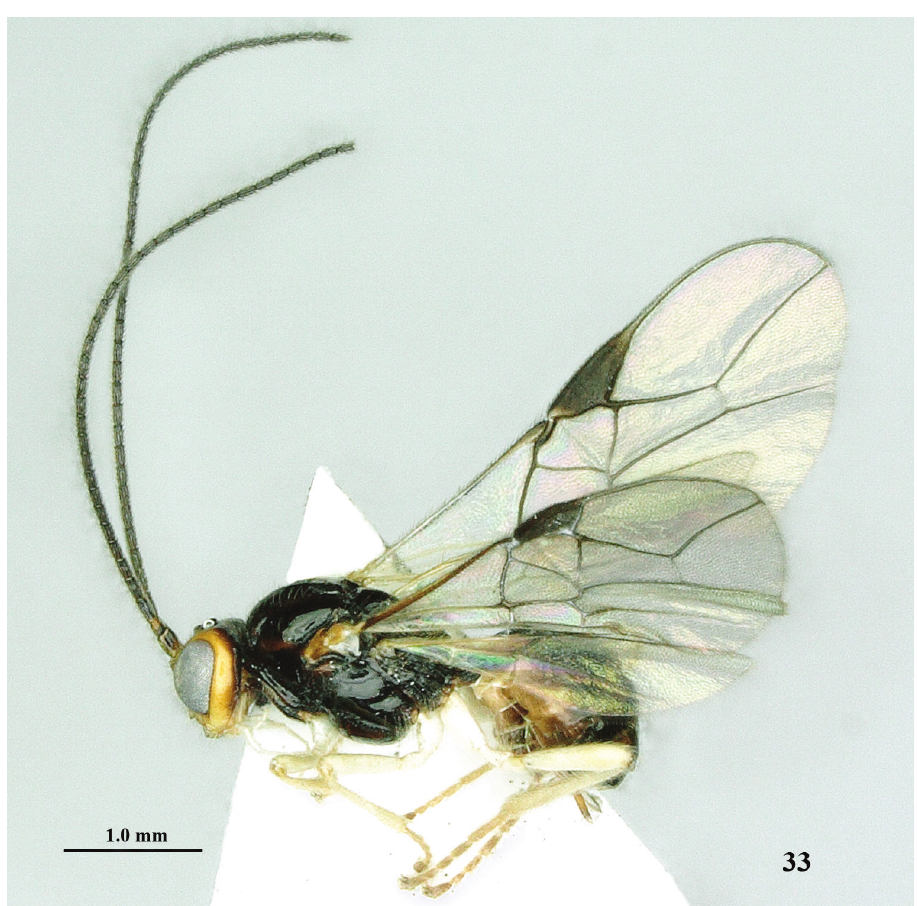
Figure 33. Rhogadopsis mediocarinata (Fischer), female, China, Liuba, habitus lateral. Additional material. 1 ♀ (NWUX), “NW China : Shaanxi , Liuba, Hanzhong Zi- bai Mt. Nat. Res., N33.66° E106.78°, 5.ix.2015, c. 1627 m, Jiangli Tan, NWUX”; 1 ♀ , “NW China: Shaanxi, Liping Nat. For. P., MT1+2, c. 1495 m,